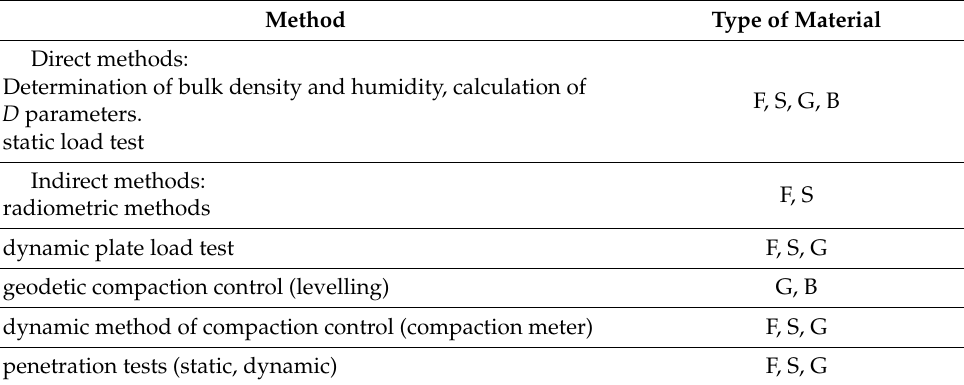
Table 1. Testing methods to detect degree of compaction used in Slovak republic. Method Type of